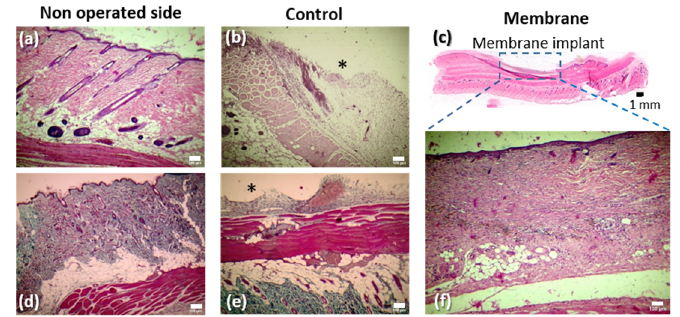
Figure 11. Representative microphotographs depicting the typical histological presentation of the wound in the control and membrane groups, as well of that of the non-operated side of the dorsal skinfold of the rat on the 21st postoperative day. Hematoxylin-eosin stain was used in the upper row of images ( a , b ), whereas Masson’s Trichrome was used in the lower row of images ( d – f ) (white scale bar = 100 μ m;); * stands for granulation tissue; ( c ) illustrates at a low magnification the two layers of the skin in the defect region.